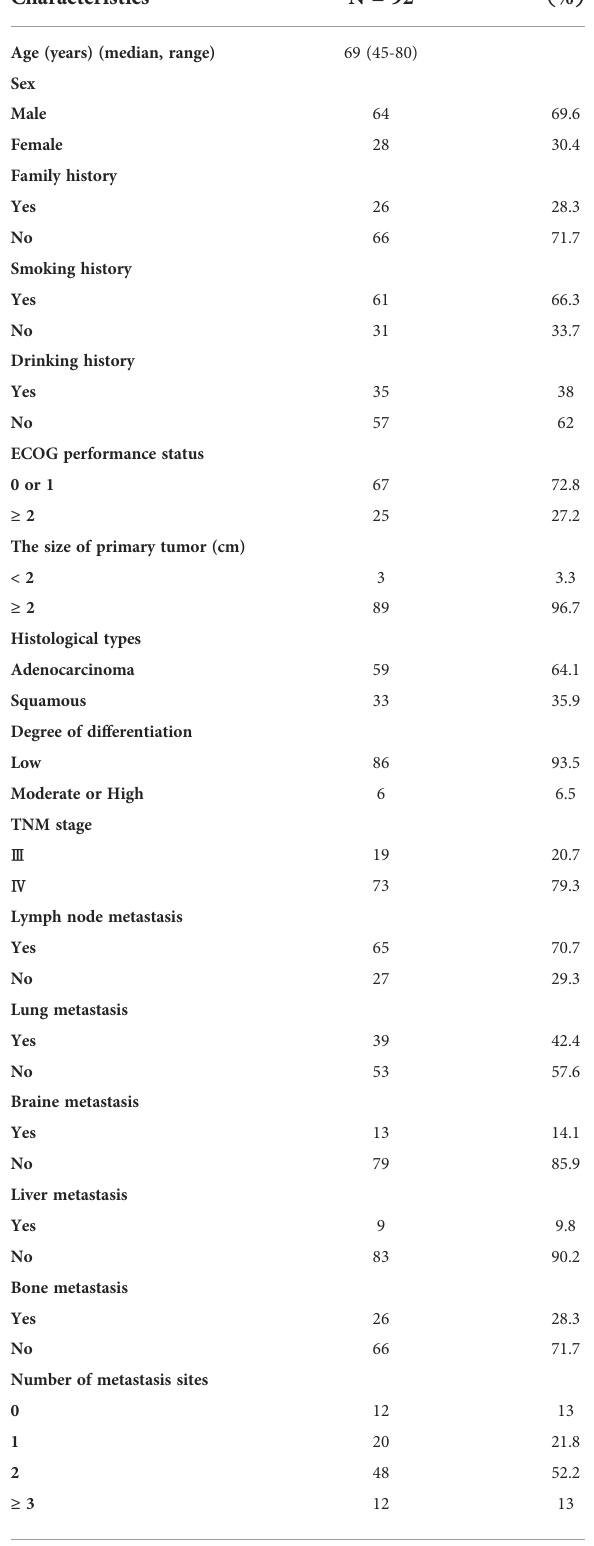
TABLE 4 The baseline characteristics of aNSCLCs who received